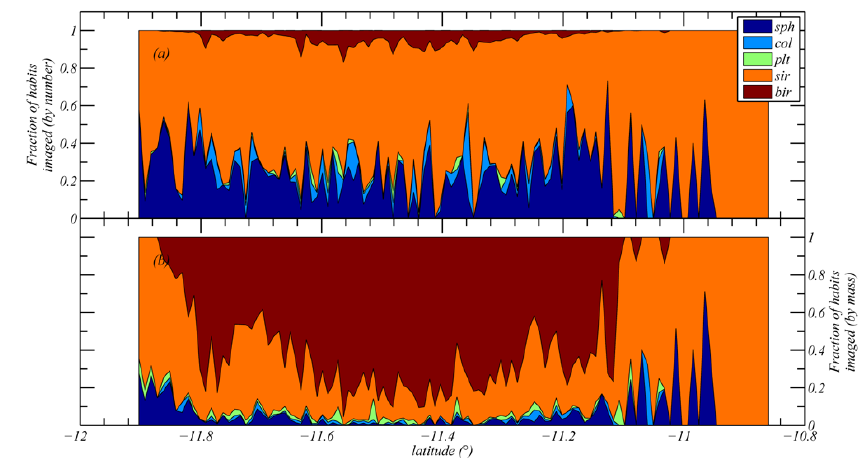
Fig. 9. CPI habit fraction analysis as a function of latitude for leg 1. Top: the relative fraction of each crystal habit by number as determined with the CPI. Bottom: same but by